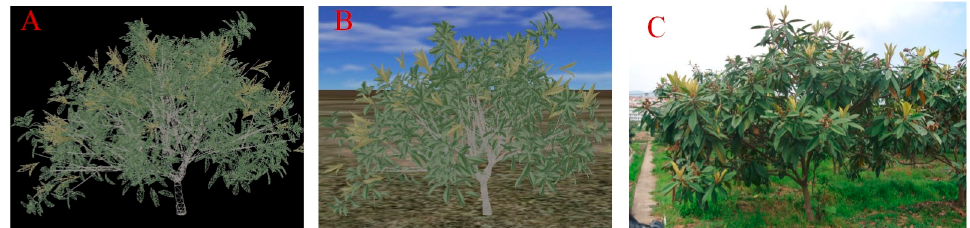
Figure 2. The 3D Muluo loquat model produced by ParaTree. ( A )Wireframe ( B ) solid and ( C ) image of a real loquat tree by camera.